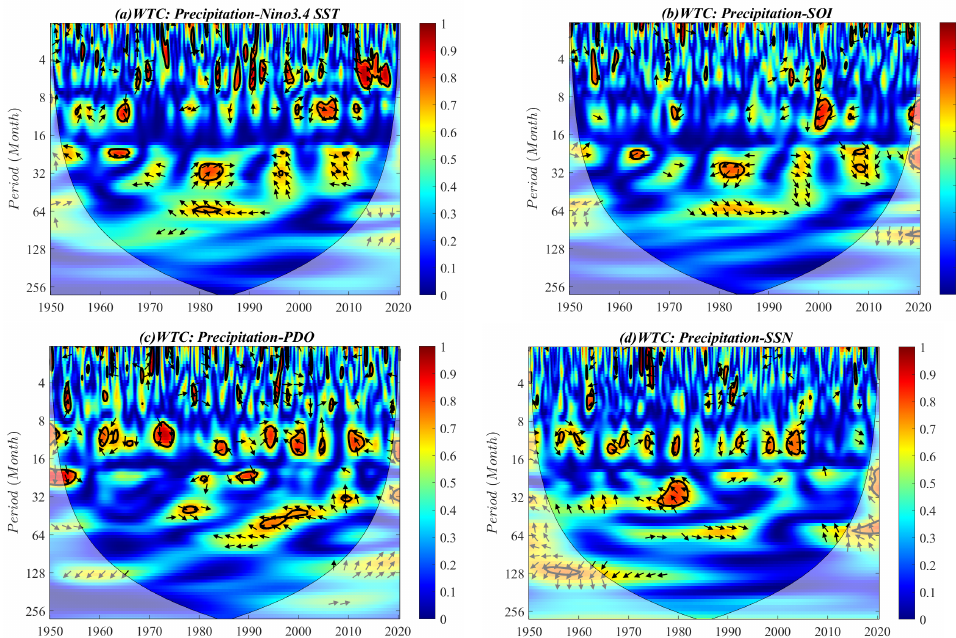
Figure 9. Wavelet coherent spectrums between monthly precipitation and telecorrelation indexes time series. ( a ) Precipitation-Nino3.4 SST; ( b ) Precipitation-SOI; ( c ) Precipitation-PDO; ( d )